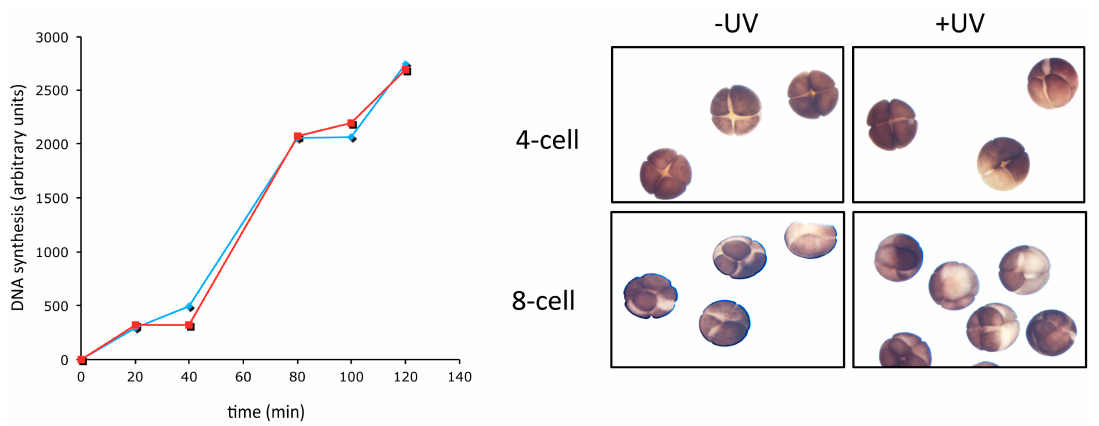
Figure 4. S ‐ and M ‐ phases of early embryos are insensitive to DNA damage. DNA synthesis ( left ); images of Xenopus laevis embryos fertilized in vitro ( right ), cleaving in the absence (blue line and − UV) or presence (red line and +UV) of moderate doses of UV ‐ C irradiation (300 J/m 2 ). Exposure to higher UV doses results in a cell cycle block due to non ‐ specific cross ‐ link of proteins to chromatin and failure to decondense chromosomes.